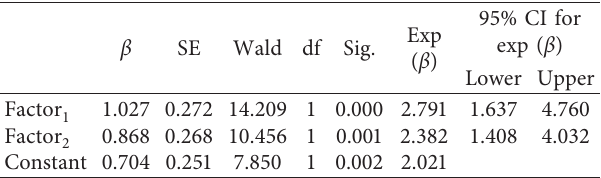
Table 10: PCA logistics regression values of the predicting